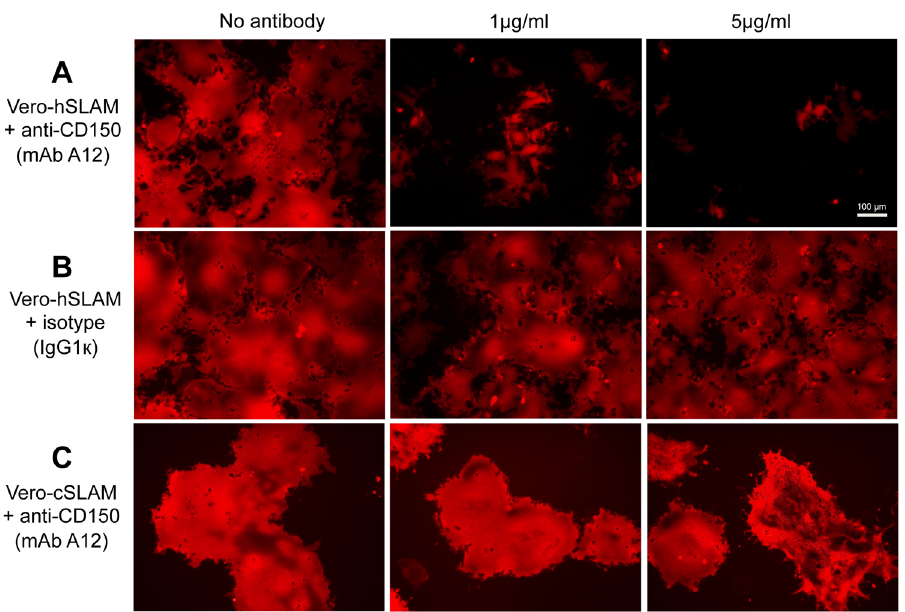
Figure 3. Infection with human CD150-adapted CDV-A75/17 red is specifically inhibited by CD150 antibodies. Vero-hSLAM cells were infected in the absence and presence of increasing concentrations of human CD150-specific monoclonal antibody A12 ( A ; 1 and 5 m g/ml), or isotype control antibody (IgG1k; B ; 1 and 5 m g/ml) for 2 days with human CD150-adapted CDV-A75/17 red at a MOI of 0.1. As further control Vero cells expressing canine CD150, which is not recognized by mAb A12, were infected in the absence and presence of mAb A12 ( C ; 1 and 5 m g/ml).